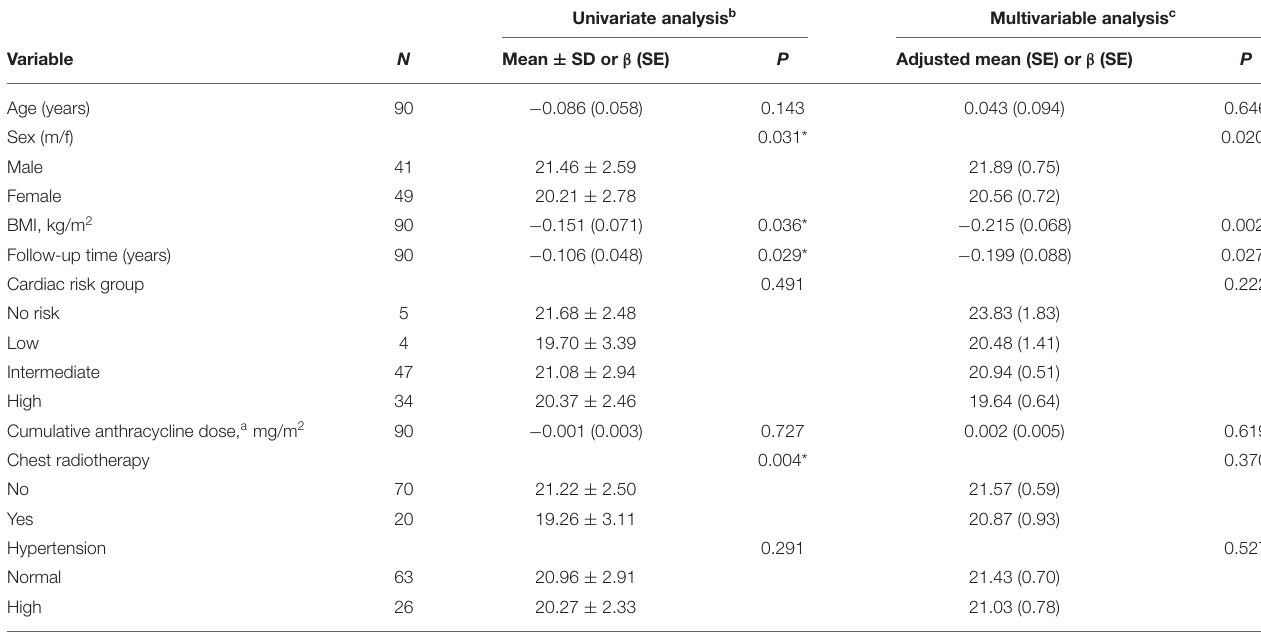
TABLE 3 | Variables associated with strain in the patient group; univariate and multivariable